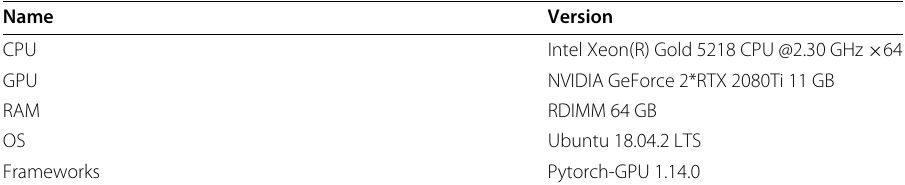
Table 1 Specific experimental